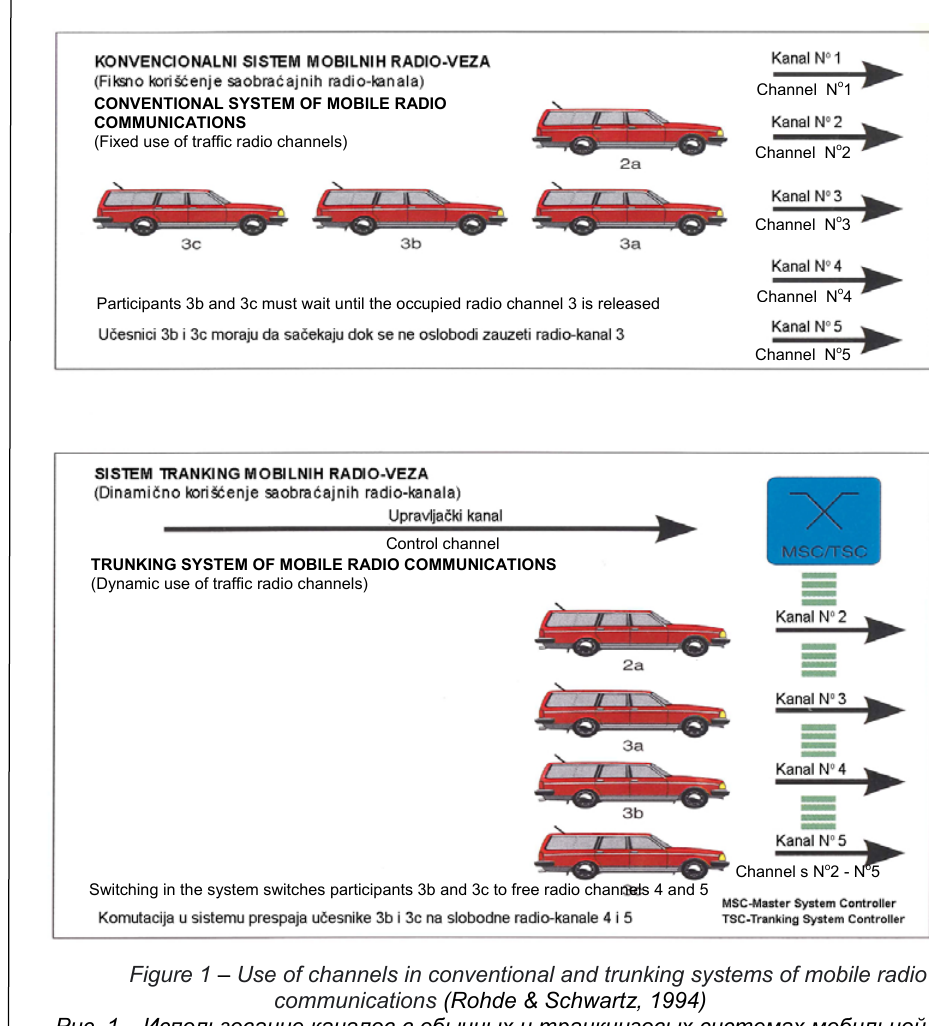
Figure 1 – Use of channels in conventional and trunking systems of mobile radio communications (Rohde & Schwartz, 1994) Рис . 1 – Использование каналов в обычных и транкинговых системах мобильной радиосвязи (Rohde & Schwartz, 1994) Слика 1 – Коришћење канала код конвенционалних и транкинг система мобилних радио - комуникација (Rohde & Schwartz, 1994)